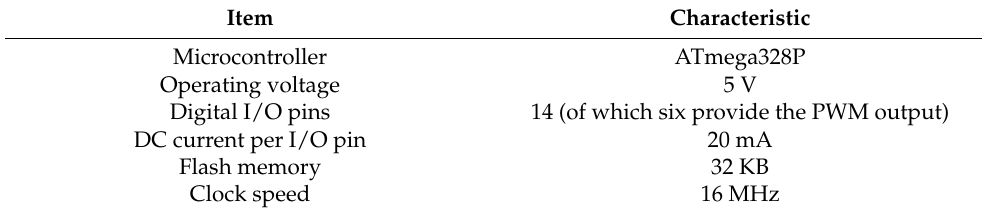
Table 2. The technical specifications of the Arduino Uno board [33].